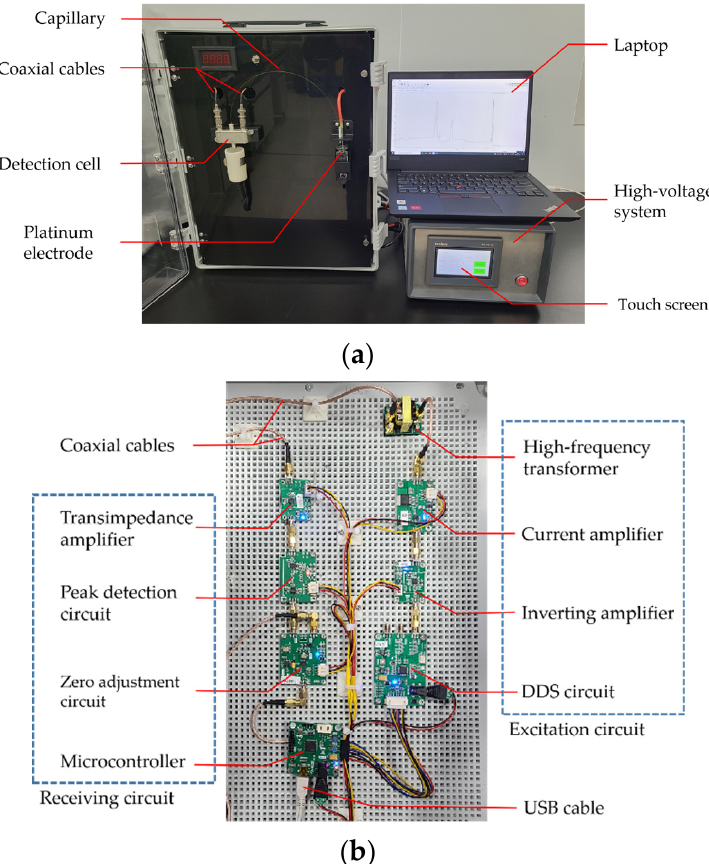
Figure 4. Images of ( a ) rapid soil macronutrient detection device and ( b ) C4D